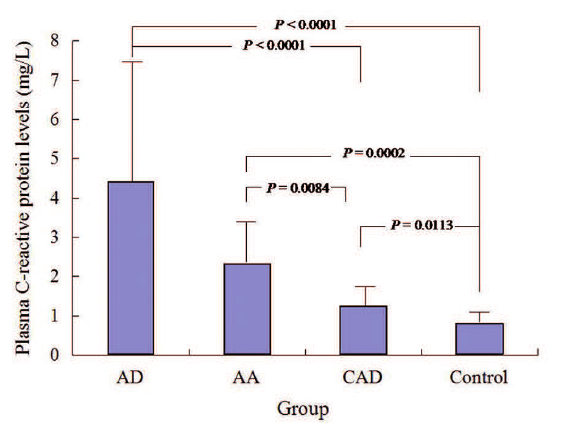
Fig. 3. D-dimers of the supernatant of the aortic tissues. AA - aortic aneurysm; AD - aortic dissection; CAD - coronary artery